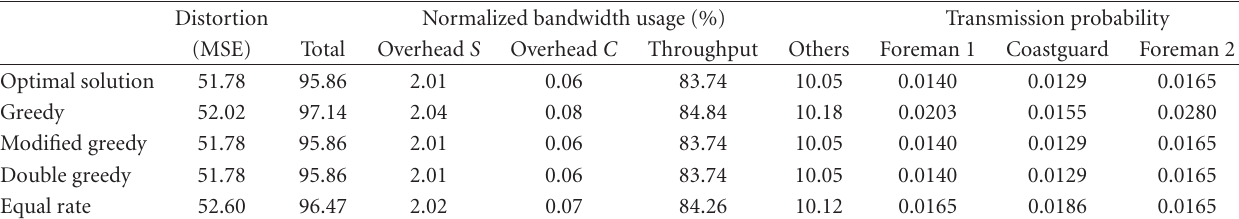
Table 6: Detail information associated with di ff erent algorithms for video profiles II (BW = 2 . 4Mb/s).